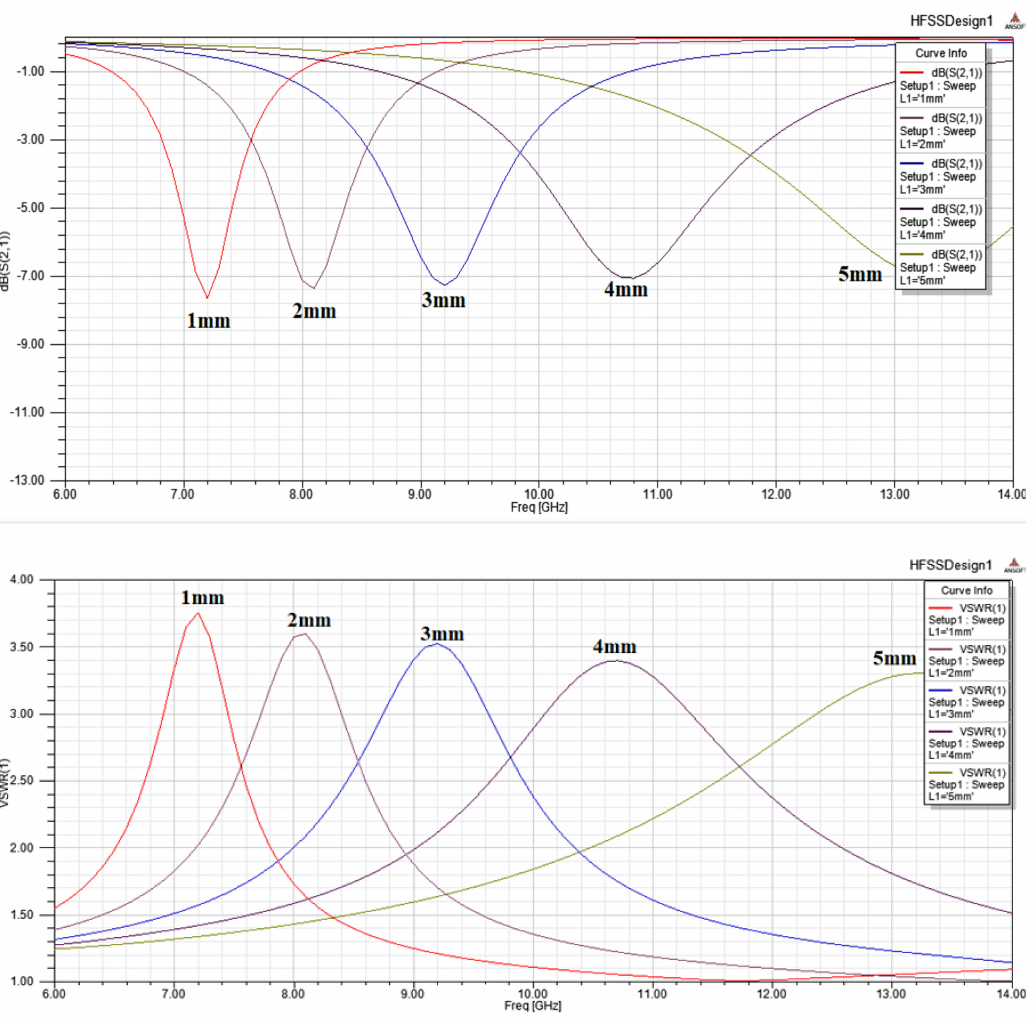
Figure 13. Transmission and VSWR curves vs frequency with the cavity length as a